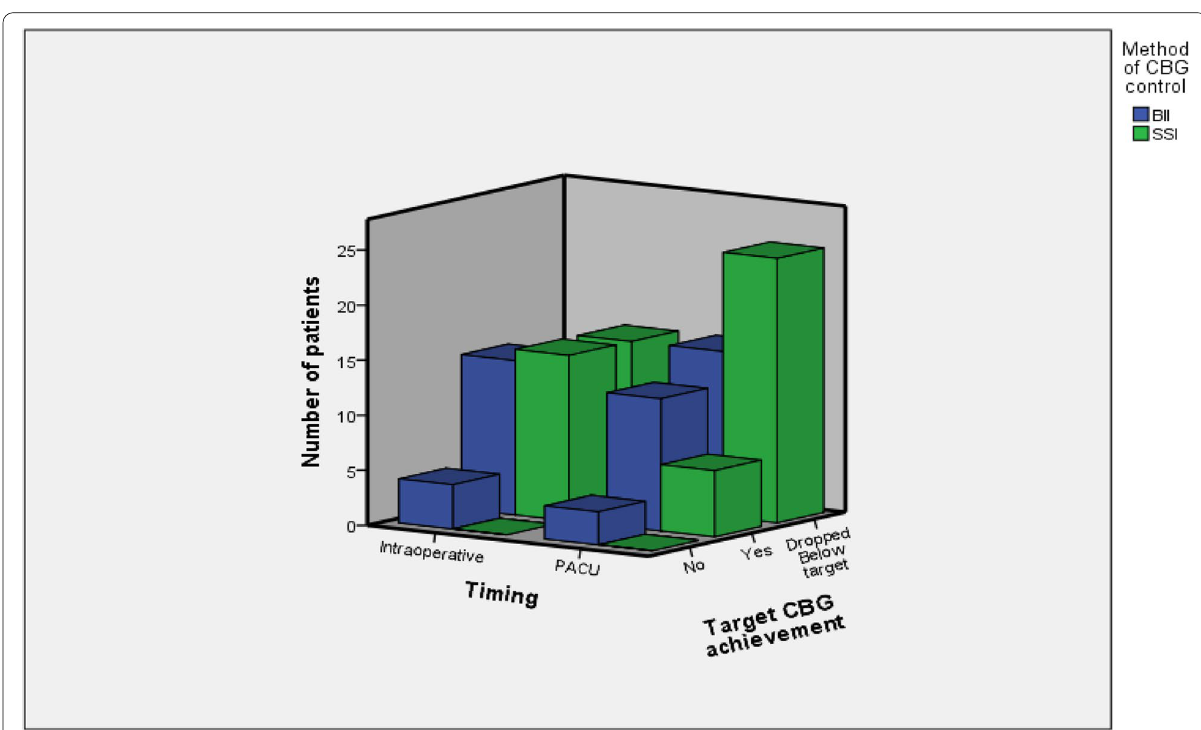
Fig. 4 Achievement of the target CBG intra‑operative and in the PACU. Data are presented as number of patients. BII: Bolus‑insulin infusion group, SSI: Sliding scale of insulin group, CBG: Capillary blood glucose, PACU: Post anesthesia care unit